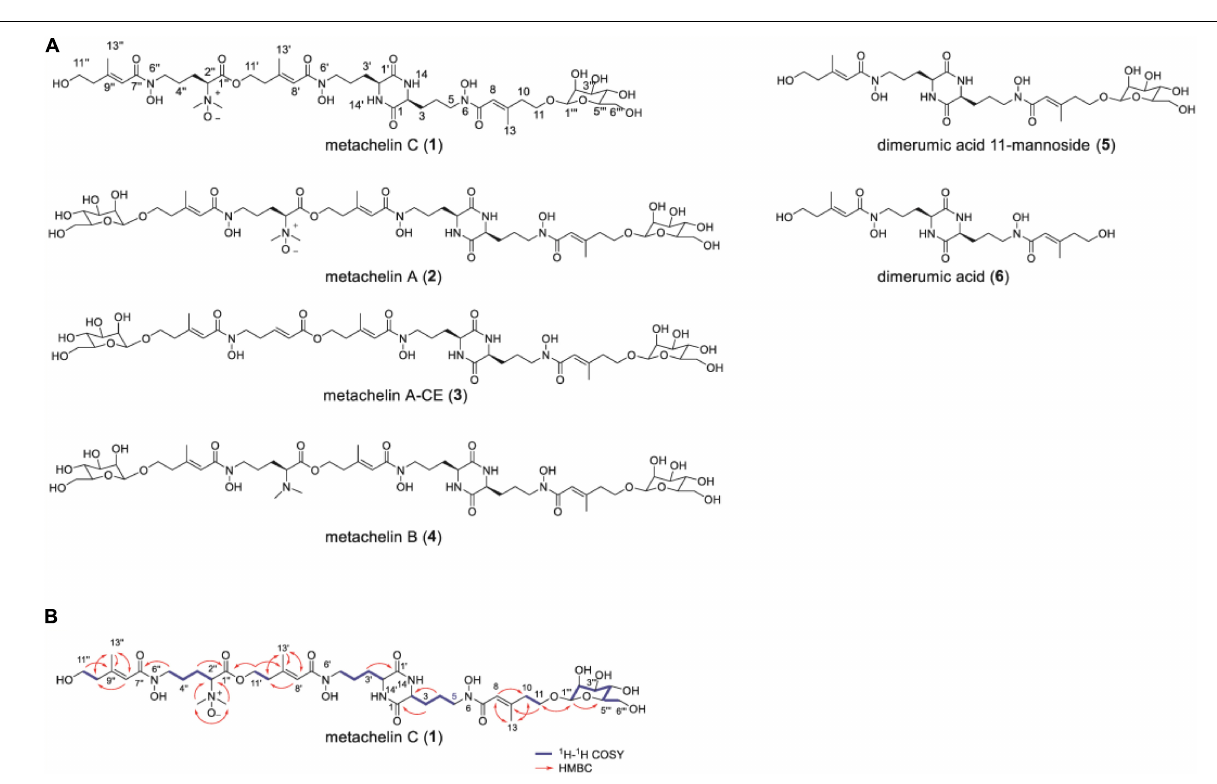
Frontiers in Microbiology |